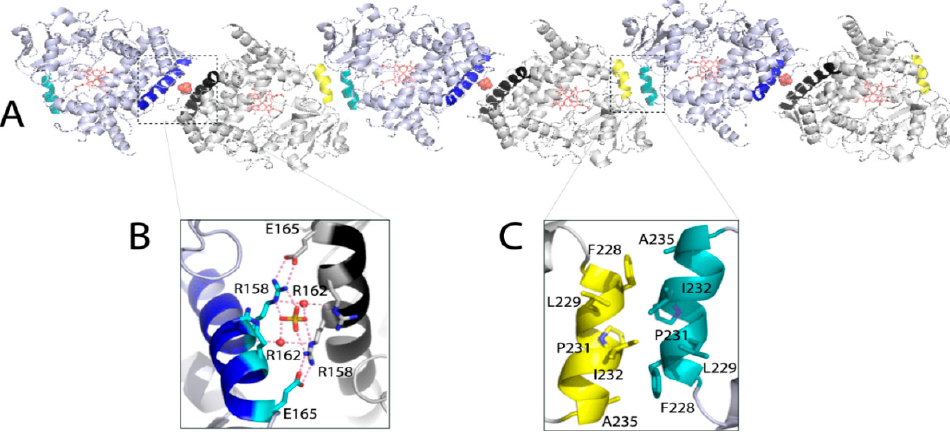
Figure 3. ( A ) Packing of CYP3A7 in the crystal lattice. Intermolecular contacts are mediated by the D-helices (in blue and black) and G ′ -helices (in yellow and teal). Sulfate ions bridging the D-helices are shown in cpk representation. ( B , C ) Magnified views at the polar and hydrophobic interface formed by the antiparallel D- and G ′ -helices, respectively. The interacting residues are displayed and labeled. Red dotted lines are H-bonds; red spheres are water molecules.